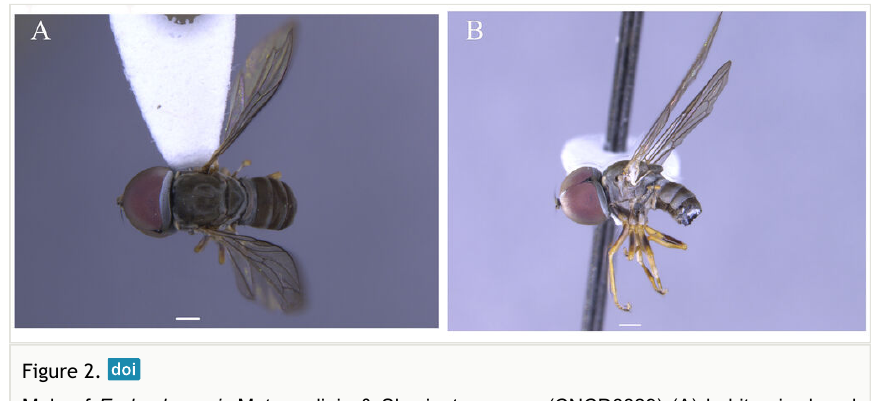
Male of Eudorylas avis Motamedinia & Skevington sp. n. (CNCD6829) (A) habitus in dorsal